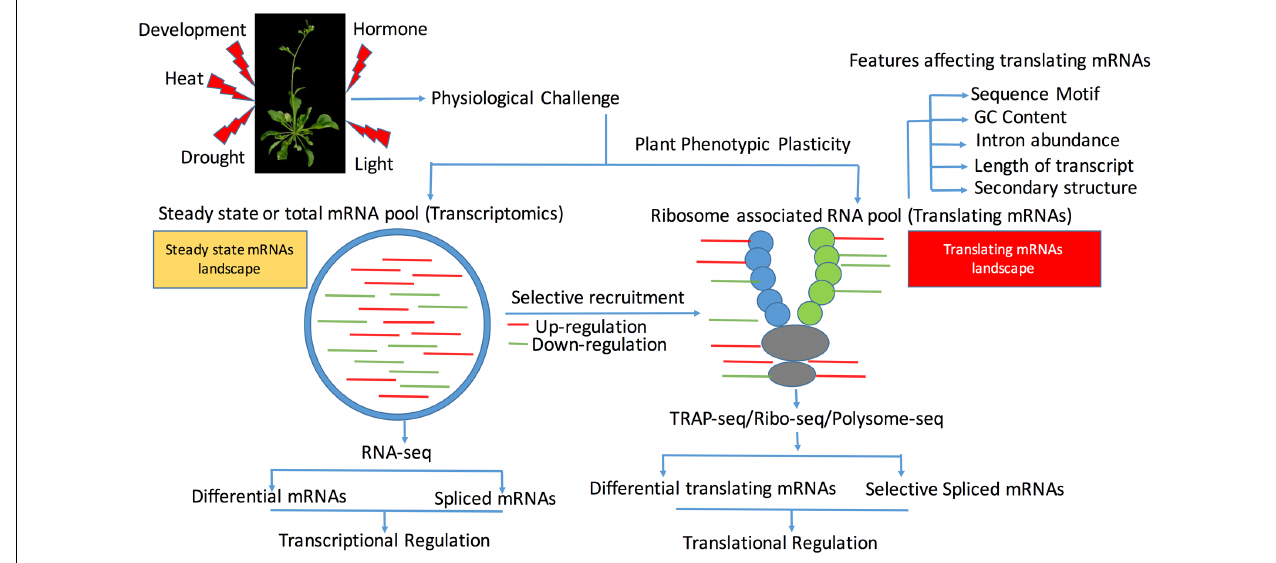
FIGURE 1 | Schematic view of transcriptional (steady state mRNAs) and translating (mRNA bounds to ribosomes) mRNAs in plants across abiotic stress and development. Induction of abiotic stress or changes in stages of development requires specific set of the transcriptional mRNAs, which is represented by the steady state mRNAs and translationally active mRNAs as represented by the ribosome bound mRNAs. Differential regulation of these steady state mRNAs and translating mRNAs play a major role in defining the phenotypic plasticity of the plant to a stress environment. Translating mRNAs represent a subset of pool of mRNAs, which are bound to ribosomes and can be identified using either intact ribosomal immunoprecipitation or TRAP-Seq, translating ribosome affinity purification (TRAP), which involves the RNA-sequencing of the purified ribosomes. To reduce the contamination of the messenger ribonucleoproteins (mRNPs), FLAG-tagged ribosomal protein L18 (RPL18) is